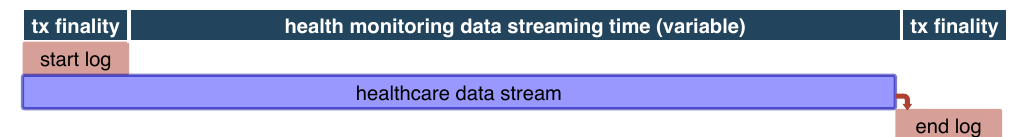
Figure 3. Timeline of health monitoring session, including start and end logs issued to